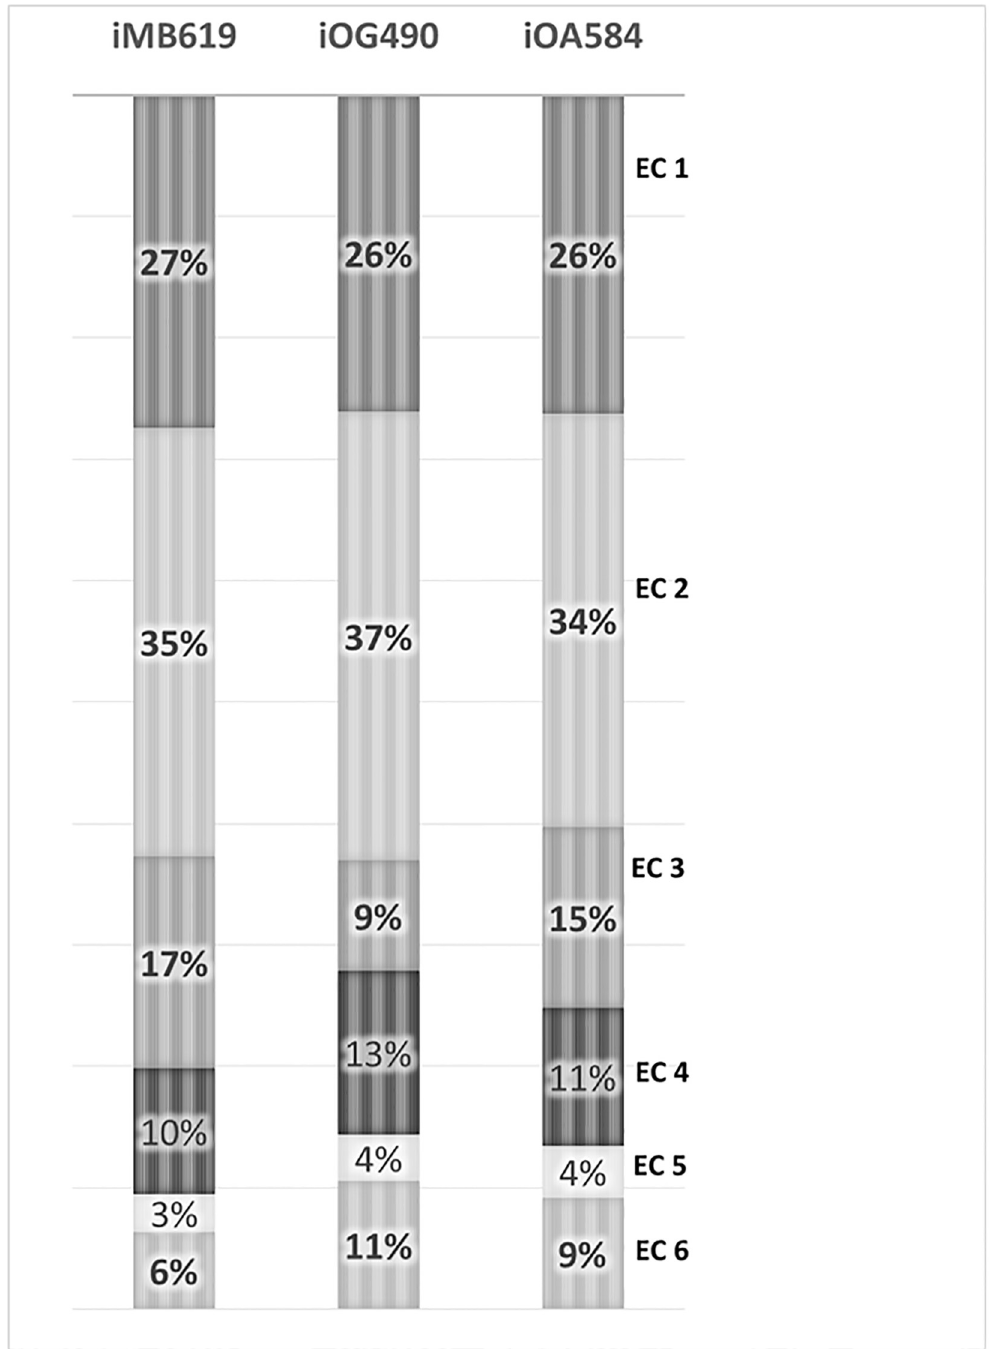
Fig 5. Enzyme classes in i MB631, i OA584 and i OG490. Transferases (EC 2) are the main category of enzymes in all three models whereas isomerases (EC 5) comprise the smallest set. Category of hydrolase (EC 3) enzymes depleted considerably in the archaeal model in comparison to bacterial